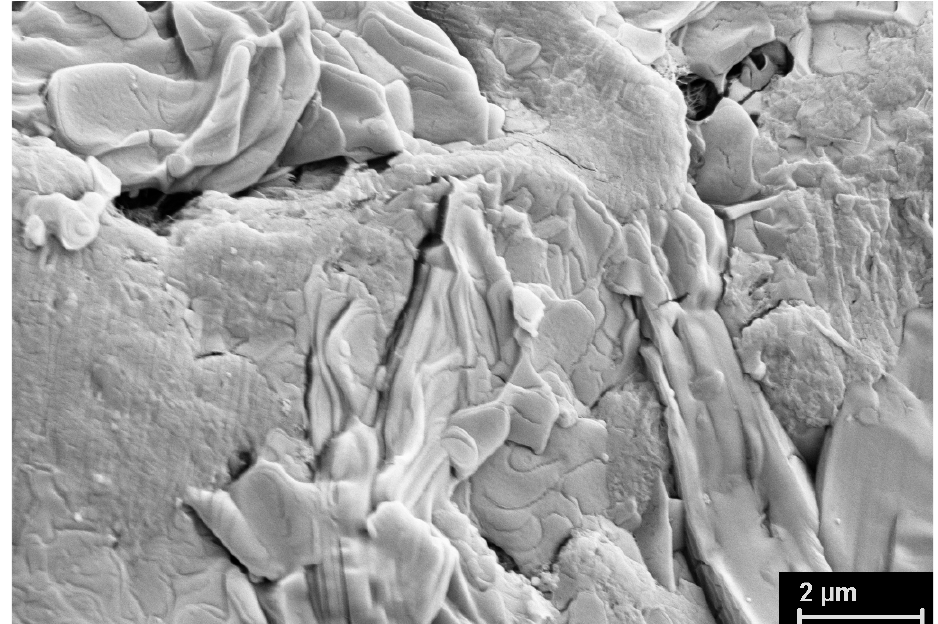
Figure 12. SEM micrograph of SC reactor powder.